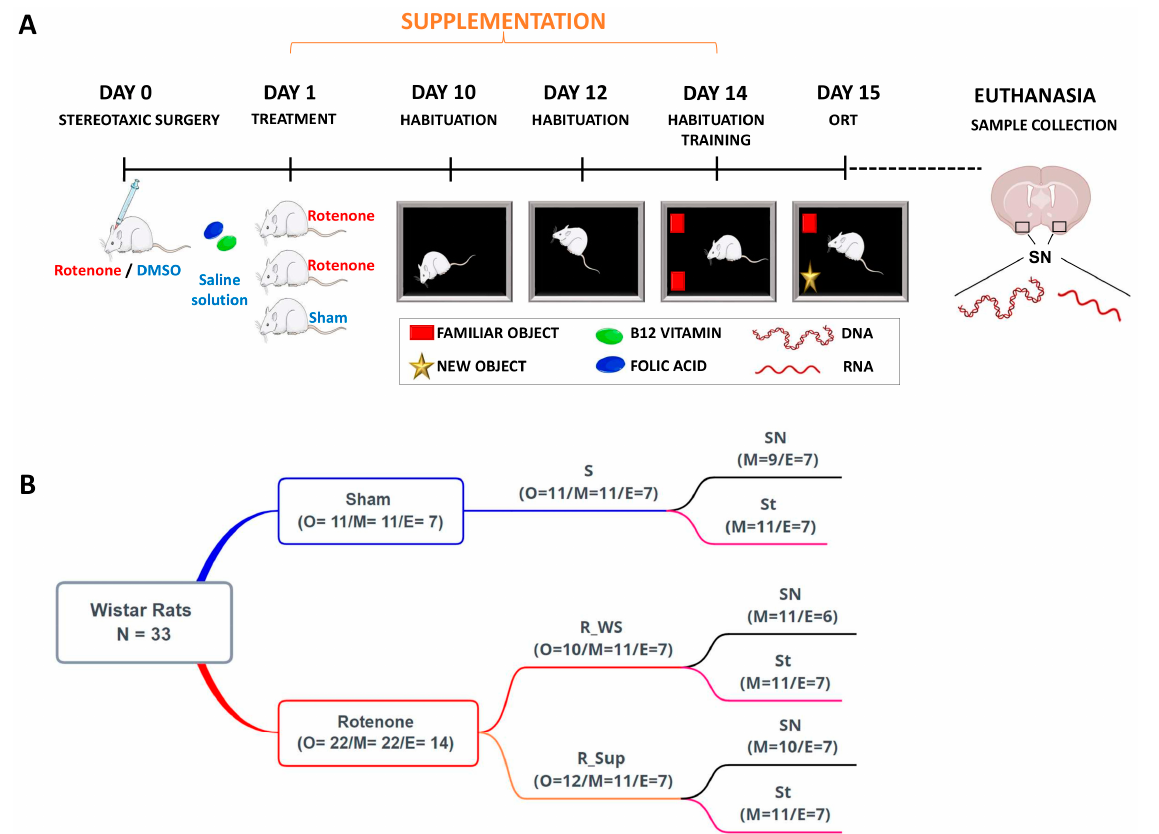
Figure 1. Experimental design. ( A ) The animals were subjected to stereotaxic surgery for rotenone or dimethylsulfoxide (DMSO) administration within the substantia nigra pars compacta . The rats were distributed into three groups: two without supplementation (WS) — rotenone (R_WS) and sham (S); one with B12 vitamin and folic acid supplementation (Sup) — rotenone (R_Sup). The animals were subjected to the object recognition task test (ORT). For molecular analysis, DNA and RNA were extracted from the substantia nigra (SN) and the striatum (St). ( B ) Animal numbers for each experiment. It is important to note that n = 33 corresponds to the maximum number of animals used, but only 21 samples were available in the expression analysis. Within parentheses: number of individuals for each experiment. O = object recognition task; M = methylation pattern analysis; E = gene expression analysis.